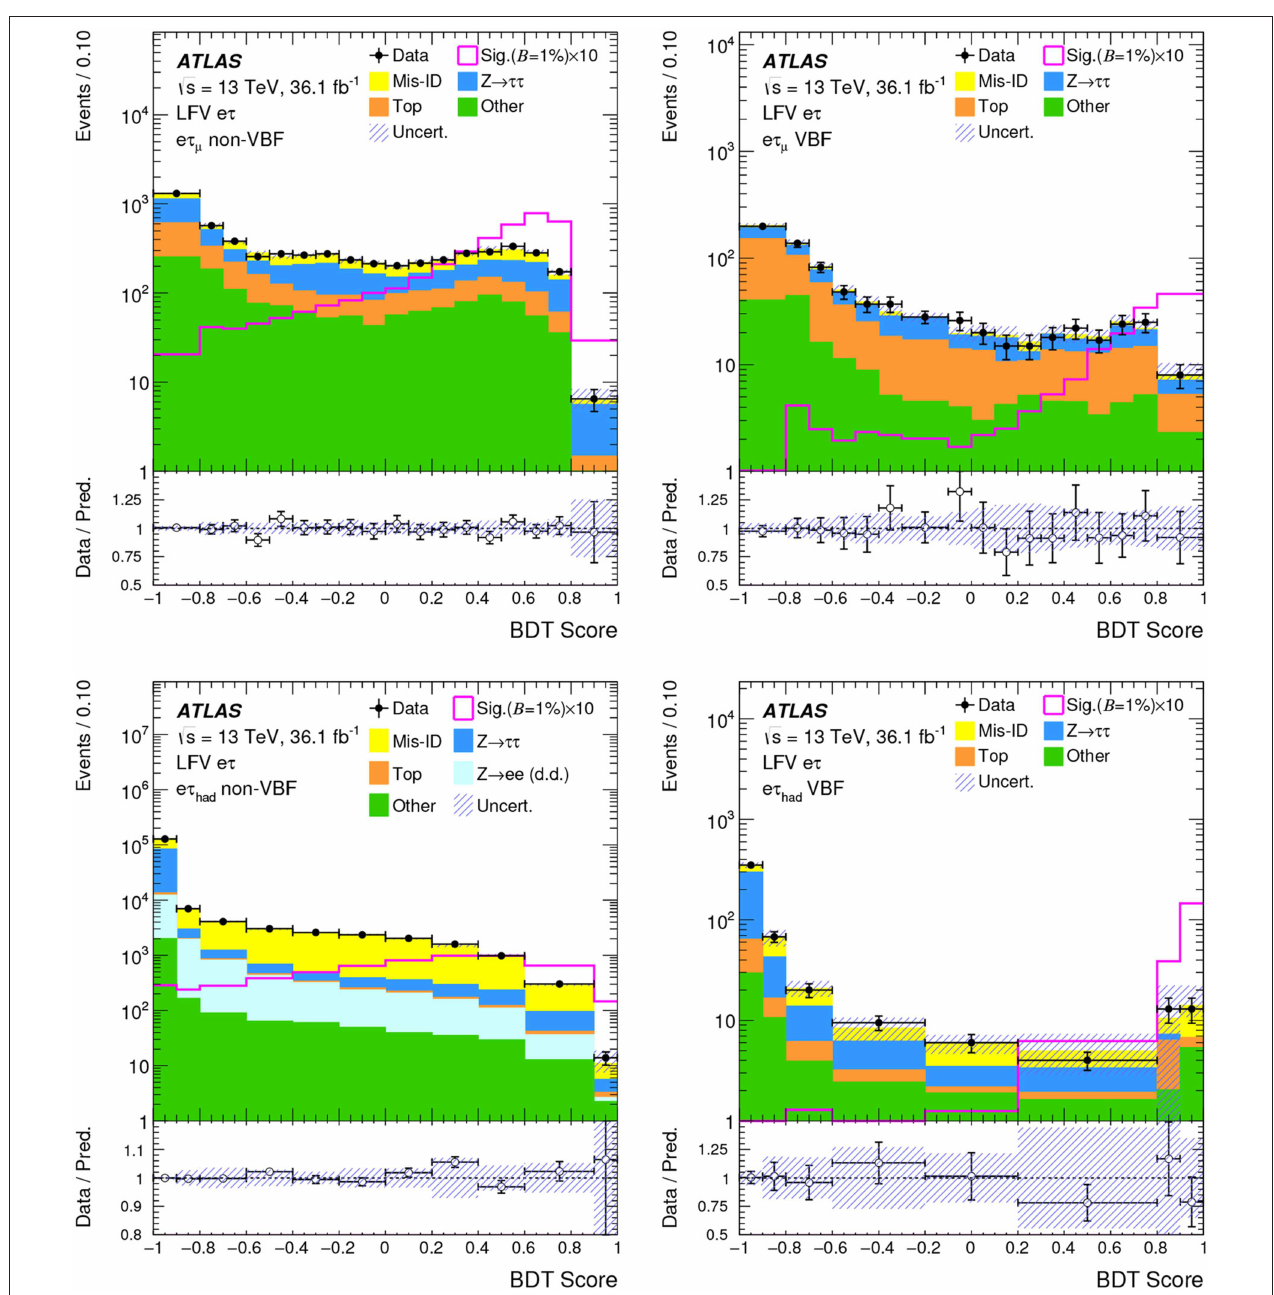
FIGURE 2 | Distributions of the BDT score after the background+signal fit in each signal region of the e τ search, with the LFV signal overlaid, normalized with B ( H e τ ) 1 % and enhanced by a factor 10 for visibility. The top and bottom plots display e τ µ and e τ had BDT scores, respectively, the left (right) column → = corresponds to the non-VBF (VBF) category. The size of the combined statistical, experimental and theoretical uncertainties of the background is indicated by the hatched bands. The binning is shown as in the statistical analysis. Reproduced from ATLAS Collaboration [49] under the Creative Commons CC-BY-4 license.